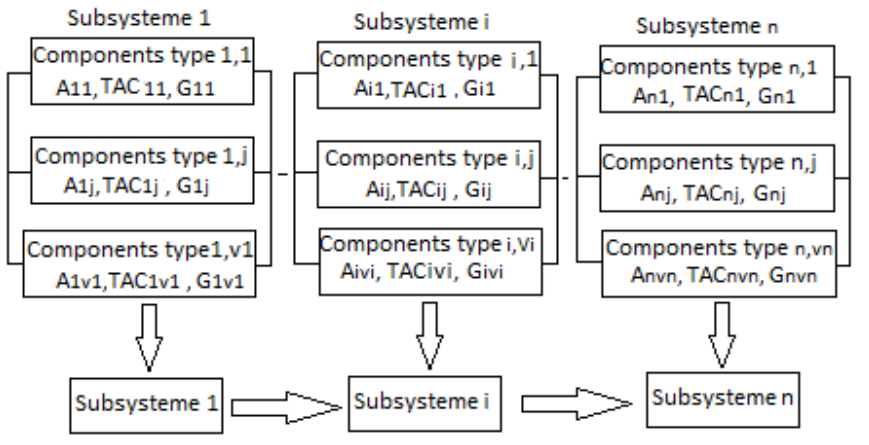
Figure 2. Series-parallel configuration system.